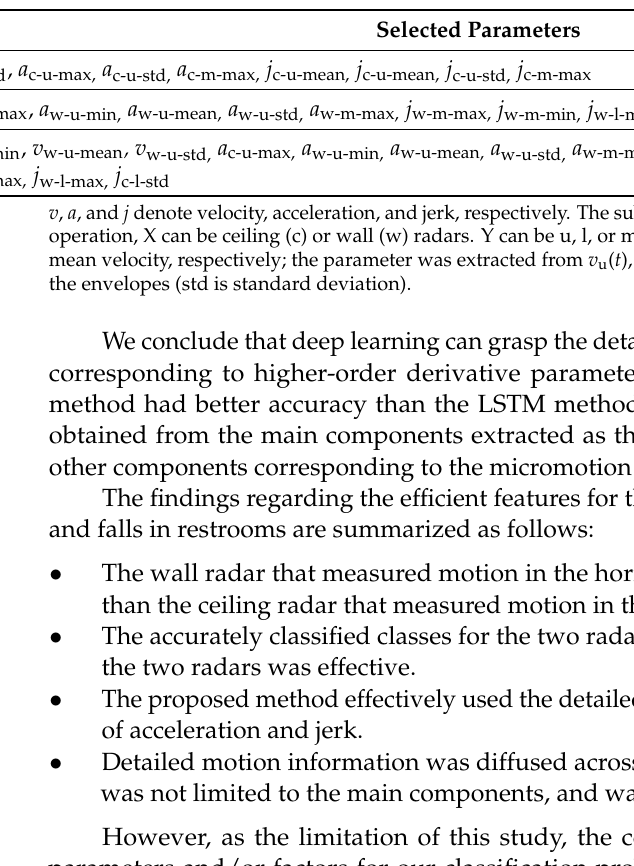
Table 6. Selected feature parameters for the RF and SVM